Question: What caption would you write for this figure?
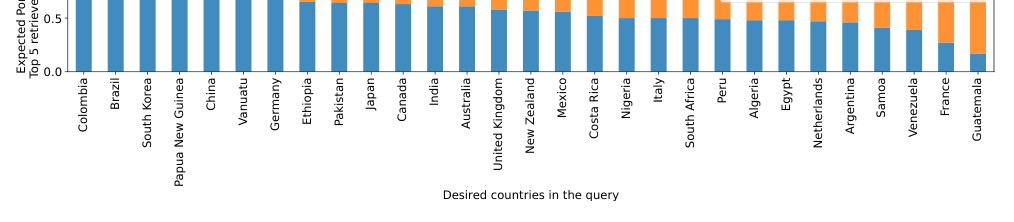
Answer: Expected portion of news articles from the desired or other countries in the top 5 retrieval results with SimCSE-sup on AGNews. Queries are from the location perspective, e.g., Find a news article on X topic and happen in Y, where Y is the desired country. We can observe that retrievers show imbalanced performance across countries. For example, users seeking news from Guatemala will experience a lower chance of satisfied retrieval than from Colombia. In the corpus, the numbers of articles per country are designed to be equal.